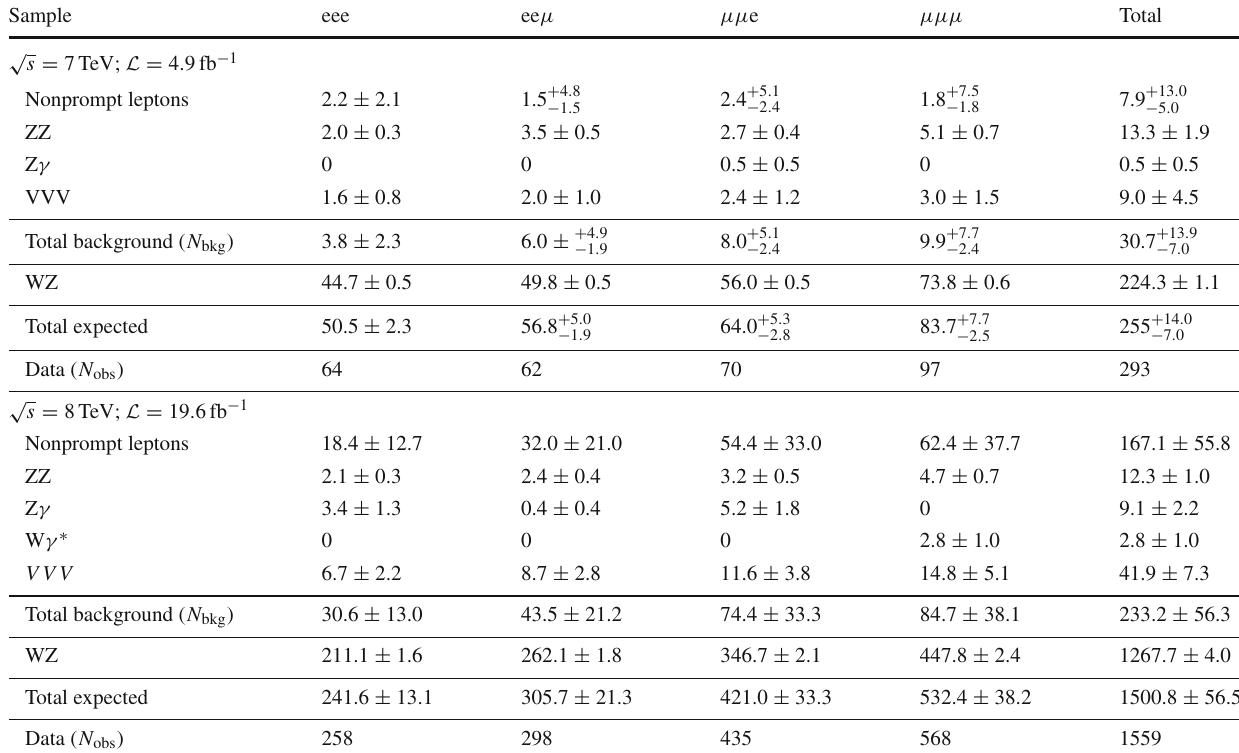
√ Table 1 Expected and observed event yields at s = 7 and 8TeV. The prised of WZZ, ZZZ, WWZ, WWW, ttW, ttZ, ttWW, tt γ and WW γ contributions from tt, Z+jets, and other processes with nonprompt lep- events, are referred to as VVV. Combined statistical and systematic uncertainties are shown, except for the WZ signal where only statistical tons have been determined from data control samples, as described in uncertainties are the text. Backgrounds with at least three bosons in the decay chain com-